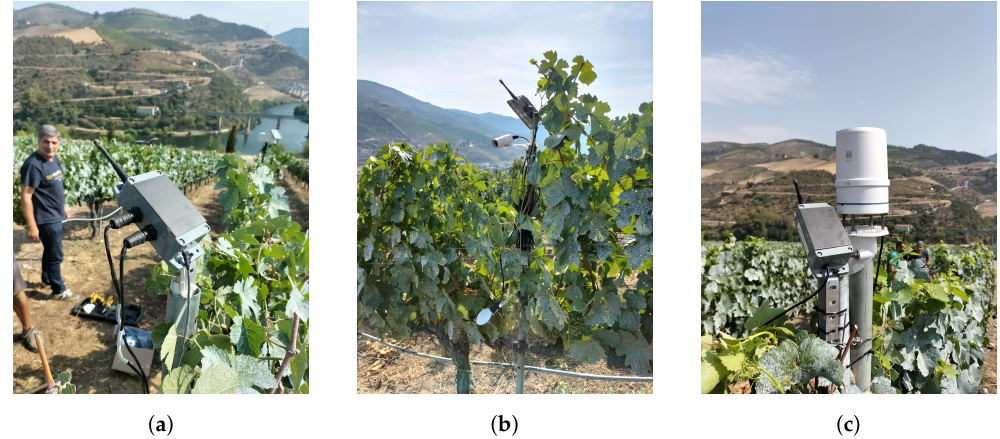
Figure 7. Images of the modules ( a ) for the ‘ SOIL ’ group, ( b ) for the ‘ PLANT ’ group and ( c ) for the ‘ ATMOSPHERE ’ group (ATMOS 41) in loco at Quinta dos